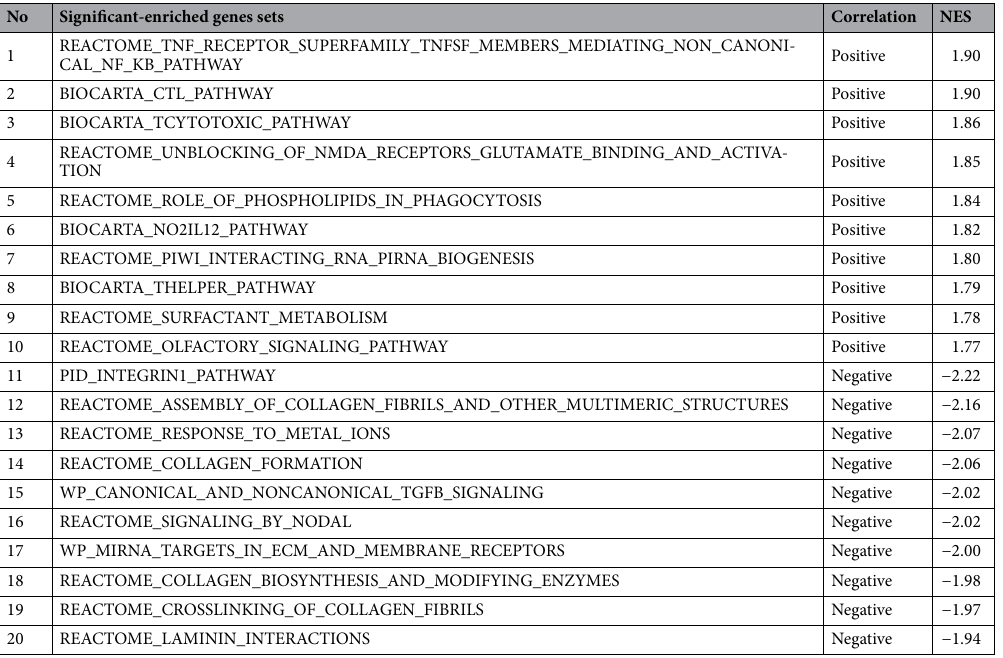
Table 2. Top-ten most significant-enriched gene sets according to NES value ranking of GSEA results positively and negatively correlated with DEGs,